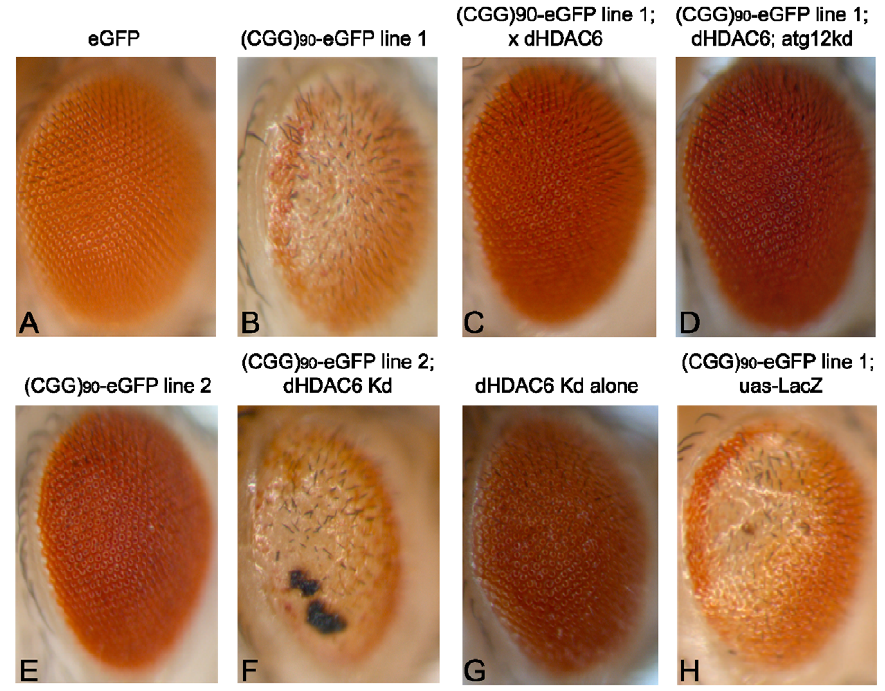
Figure 1. HDAC6 suppresses (CGG) 90 -eGFP–induced neurodegeneration by an autophagy independent mechanism. Expression of eGFP alone in the fly eye with a gmr-GAL4 driver has no notable phenotype (A). When a CGG repeat is placed in the 5 9 UTR of eGFP, a dose- and temperature-dependent rough eye phenotype develops that is more severe in line 1 (B) than line 2 (E). The severe rough eye phenotype is suppressed by co-expression of HDAC6(C). This phenotypic rescue by HDAC6 does not depend on an intact autophagy pathway, as siRNA-based knockdown of atg12 does not prevent suppression (D). The mild rough eye phenotype seen in line 2 is synergistically enhanced by siRNA-based knockdown of dHDAC6, producing a black necrotic eschar on portions of the eye(F). Of note, dHDAC6 knockdown induces a mild rough eye phenotype when expressed alone (G). As a negative control, expression of Beta-Gal (lacZ) has no effect on the phenotype. (H). All images are representative of . 100 flies per genotype and at least two separate crosses. KD = knock